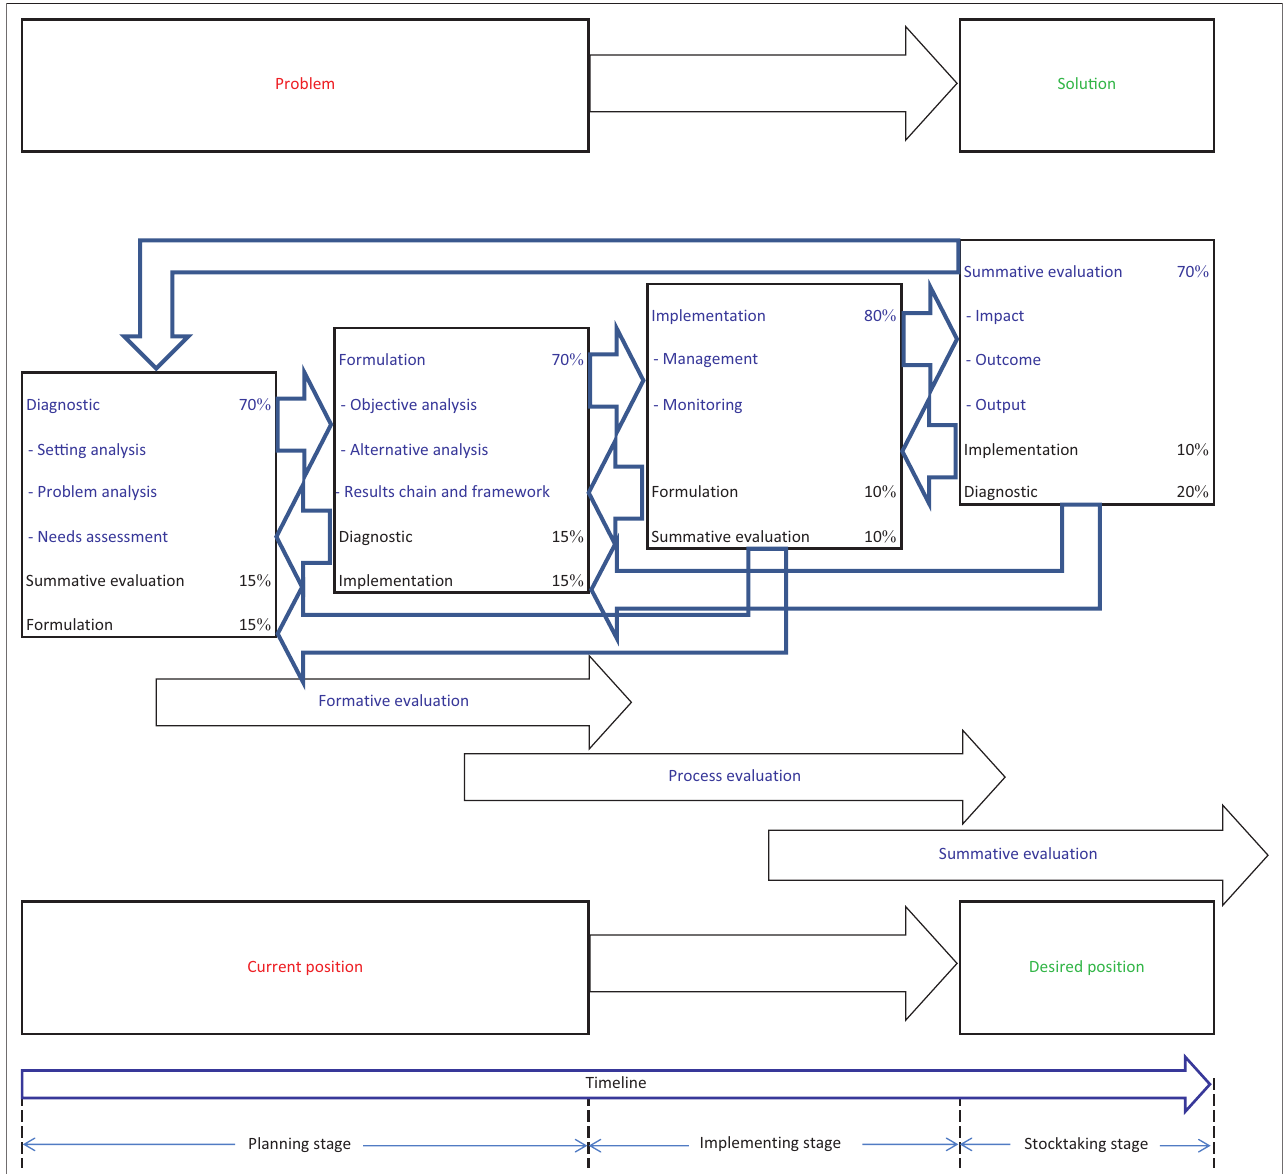
FIGURE 7: Illustrating the stages of the public policy cycle framework capturing monitoring and evaluation functions in a development